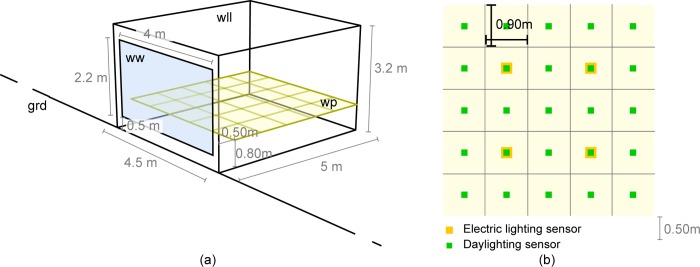
(a) Perimeter office space–window (ww) in blue, work plane (wp) in yellow—exterior / interior ground (grd), walls (wll) and ceiling indicated–(b) The grid represents the daylighting analysis grid. There is one daylight sensor per square (green). The four yellow sensors are specific to artificial lighting and are used to determine when electric lighting is needed.